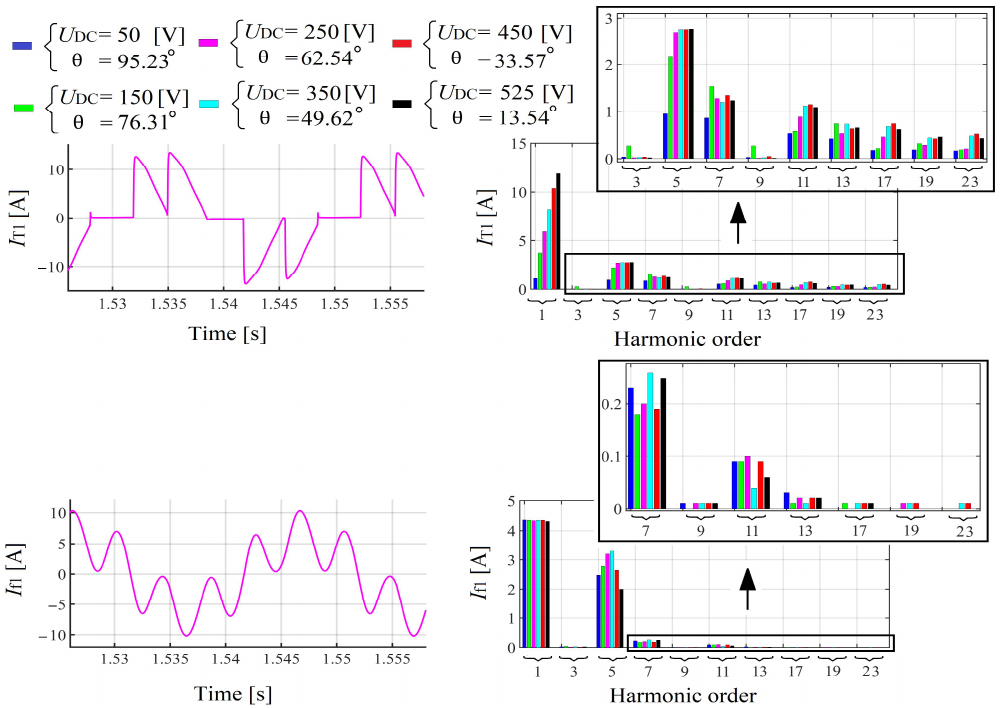
Figure 18. Input rectifier ( I T1 ) current with its spectrum and filter current ( I f1 ) with the spectrum.